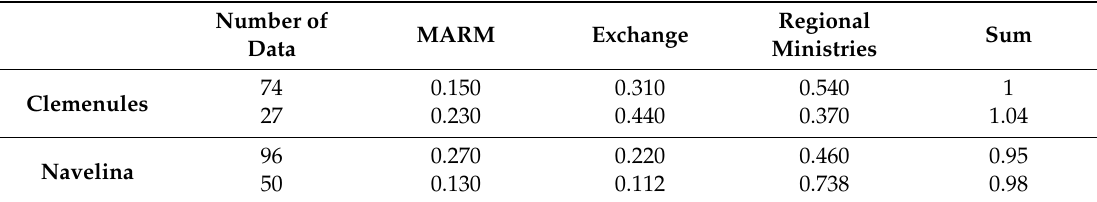
Table 6. Impact of the data on the results of the SEM